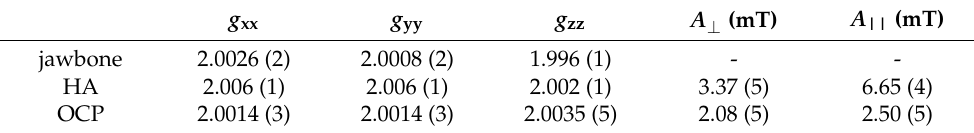
Table 1. The Spin-Hamiltonian parameters of the X-ray irradiated